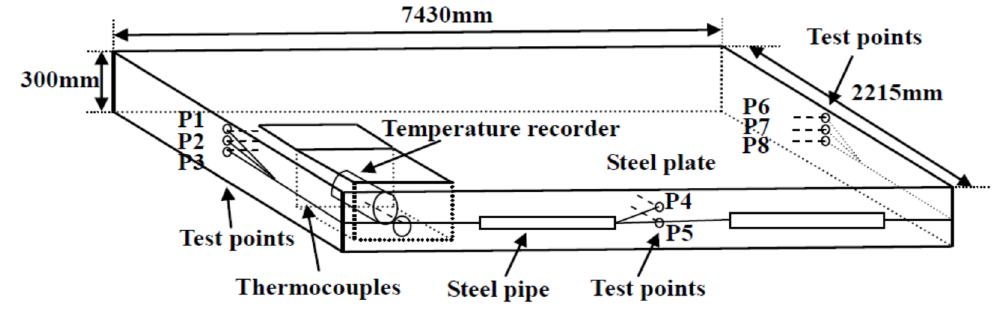
Figure 1. Schematic illustration of the 300 mm steel plate indicating the locations of the temperature measurement points.